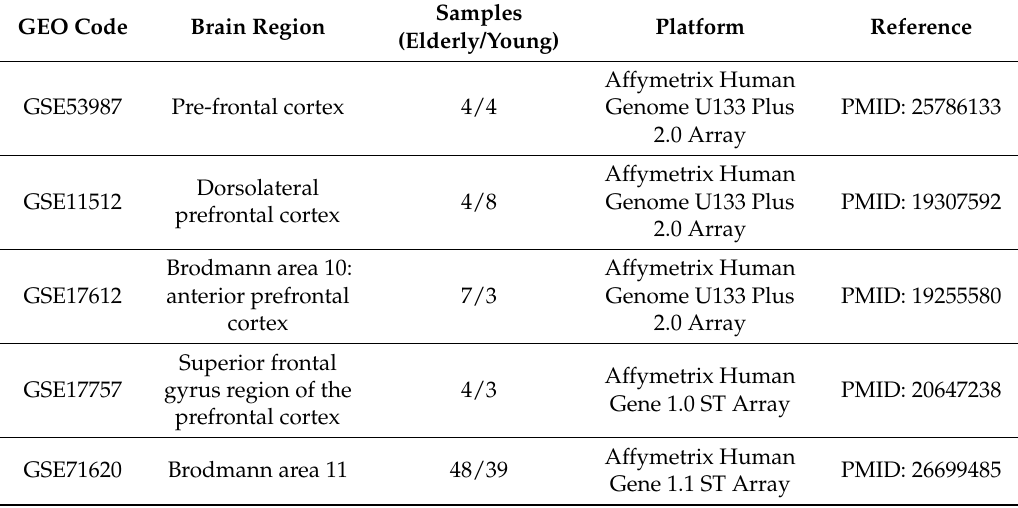
Figure 1. Workflow of the data selection. Search in PubMed and GEO database identified nine datasets involving transcriptomic analysis of prefrontal cortex (PFC) in humans. After removal of duplicates and quality control, five datasets were selected in this research. Table 1. Description of studies included in the analysis.